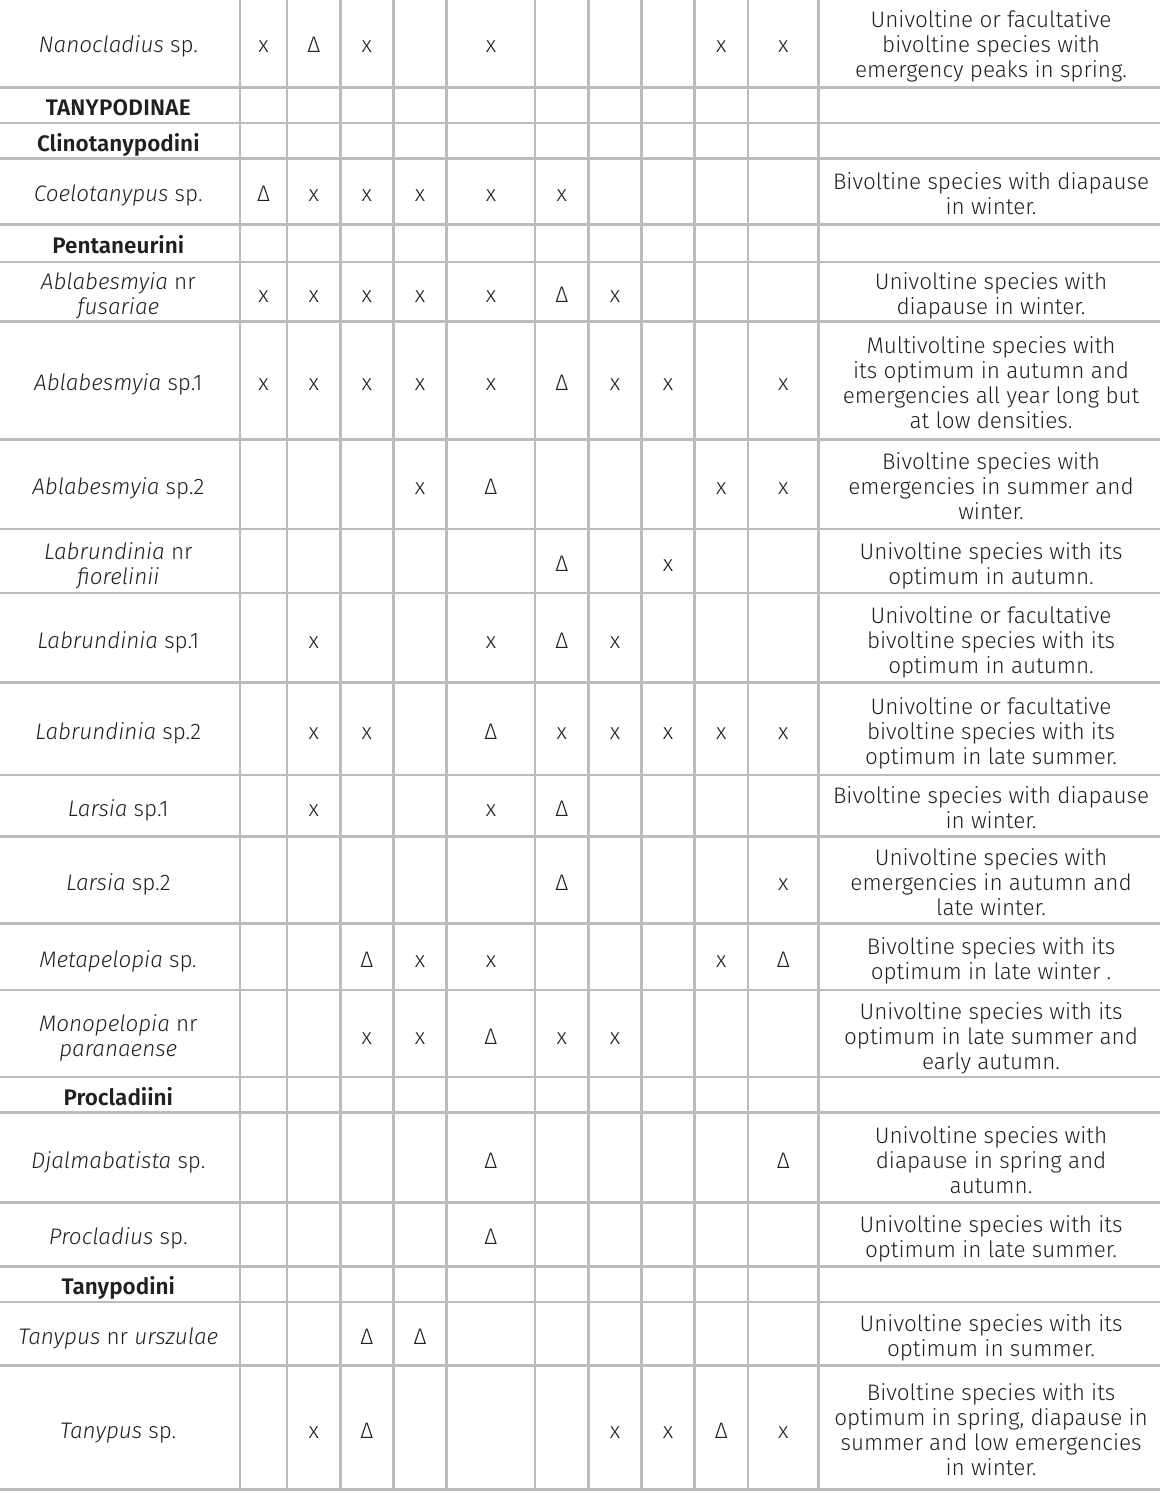
Univoltine or facultative bivoltine species with emergency peaks in spring.